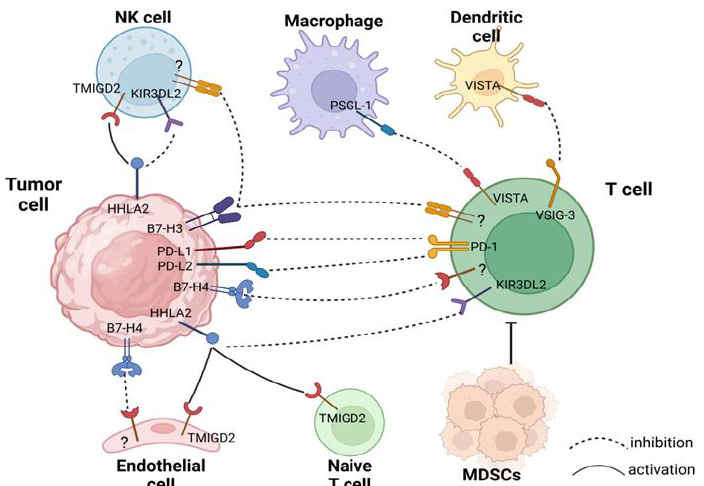
Figure 1. The B7 family members in the TME of PDAC. The B7 family members are widely expressed in the TME of PDAC, and this diagram mainly depicts the expression of these molecules in the TME, briefly describing how these molecules are involved in the interaction between tumor cells and im- mune cells and emphasizing their major role in the antitumor immune response. The dashed line indicates a major role as an immune suppressor, and the solid line indicates a major role in PDAC as an immune